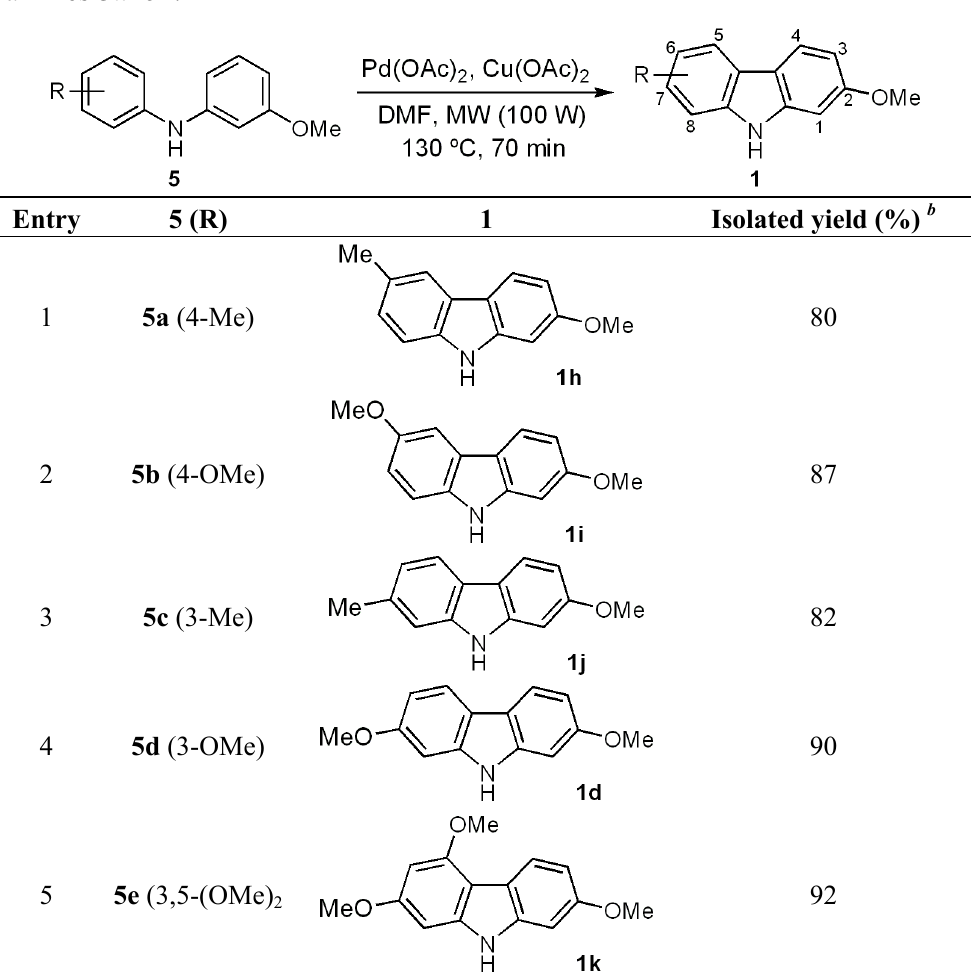
Table 3. Preparation of carbazoles 1d and 1h – k via Pd(II)-catalyzed cyclization of diarylamines 5a – e a